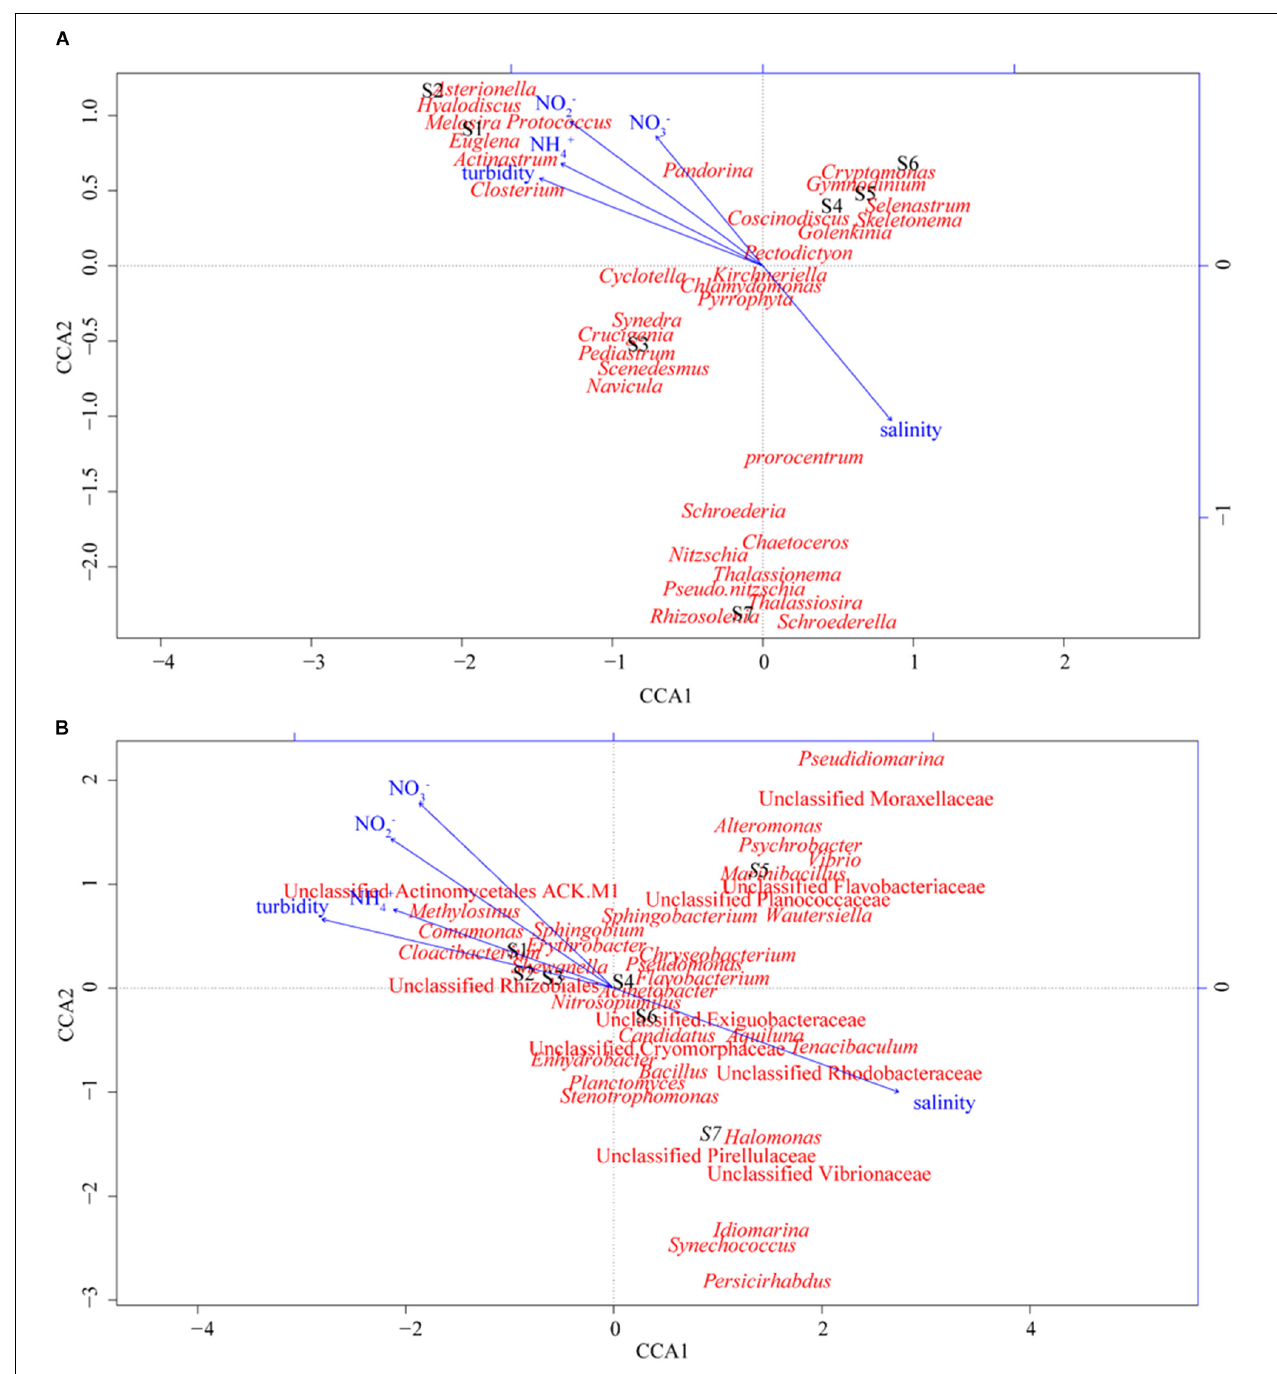
FIGURE 2 | CCA illustrating the relationship between environmental factors and microbial community structure at the genus level at different sampling sites. (A) Phytoplankton community and (B) bacterioplankton